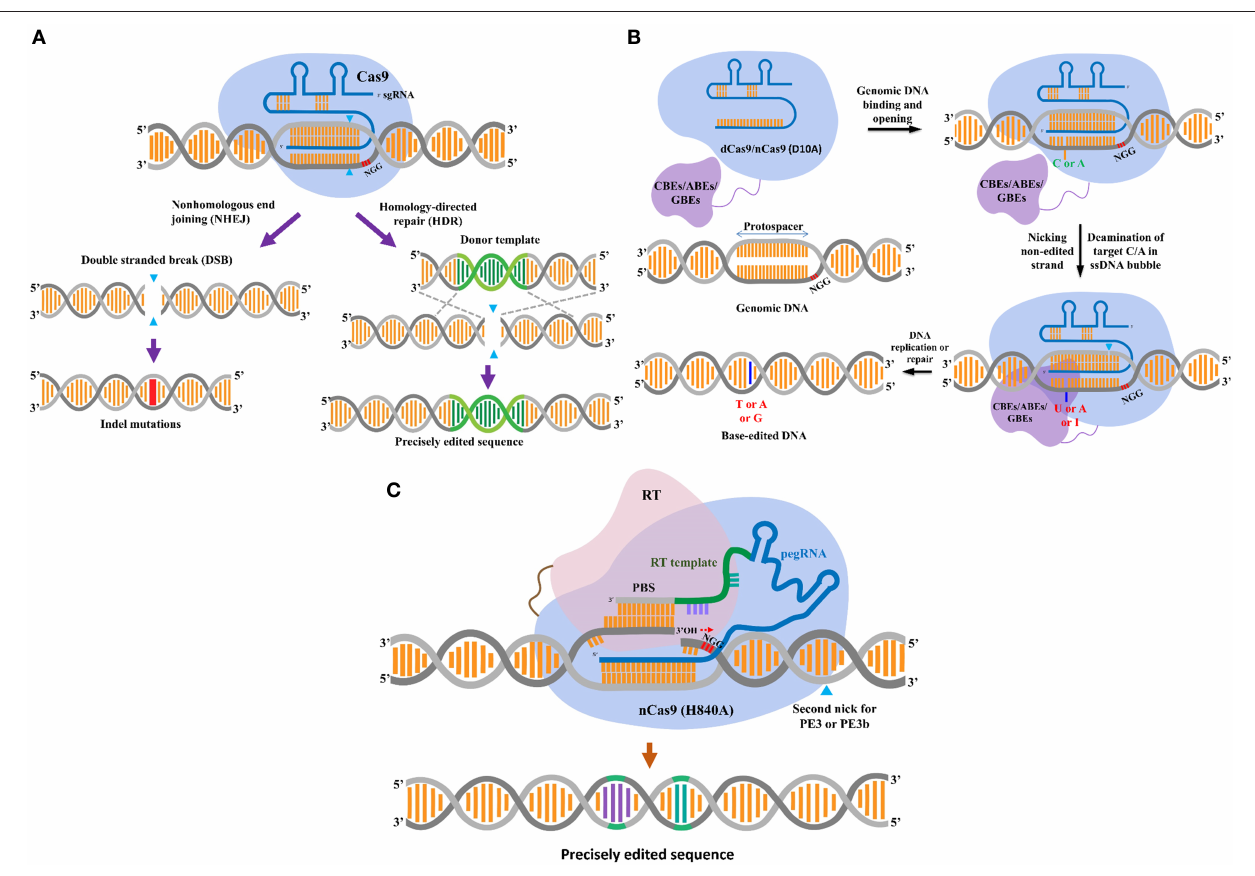
FIGURE 1 | CRISPR/Cas-based plant gene-editing tools. (A) CRISPR/Cas9-mediated double-stranded break (DSB) repair mechanism. The CRISPR-associated enzyme Cas9-sgRNA complex breaks down the target DNA to create a DSB, that leads to gene editing via two major DSB repair pathways, i.e., non-homologous end joining (NHEJ) and homology-directed repair (HDR) pathway. The blue triangles indicate locations of the cut site. The NHEJ pathway usually results in small insertions and deletions, as indicated by the red line. The HDR pathway uses a DNA donor template with two homologous ends to the DSB terminals to precisely introduce the edited sequence (green helix) into the genomic site. (B) DNA base editors. From left to right and top to down: base editors are created by fusing a dead/nickase Cas9 (d/nCas9) (light blue) to a nucleobase deaminase (in case of cytosine base editors (CBEs) and adenine base editors (ABEs), painted in purple), and a